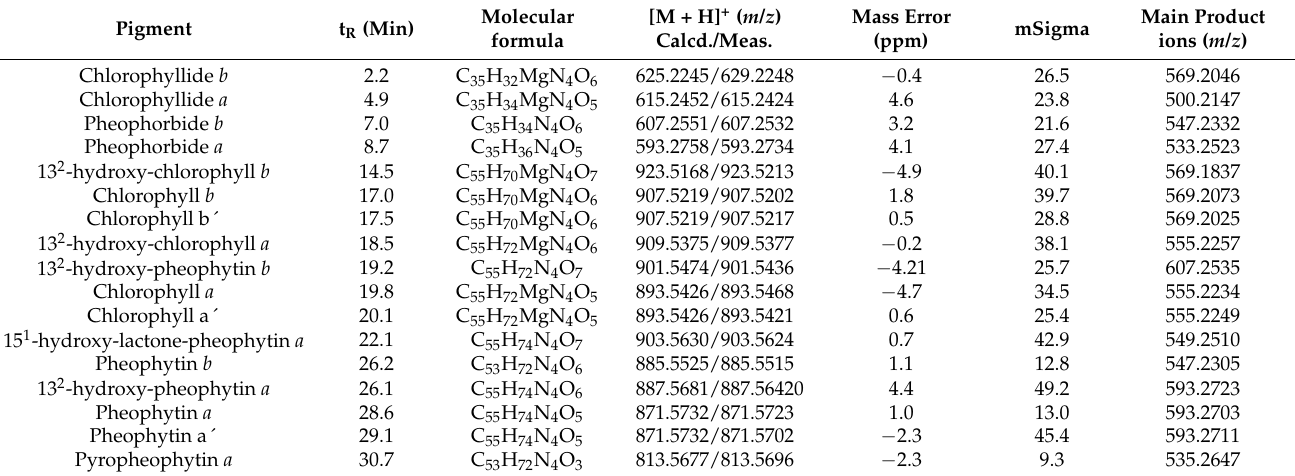
Table 1. Chromatographic and mass spectrometry characteristics of chlorophylls identified in green